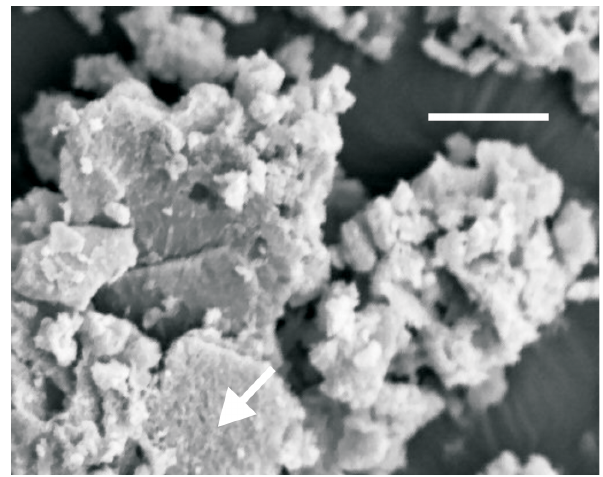
Figure 2. SEM image showing a typical aggregate of hydroxylap- atite from Gura Dobrogei. The arrow indicates a well-shaped crys- tal in the bottom-central part of the photograph. The scale bar (top) represents